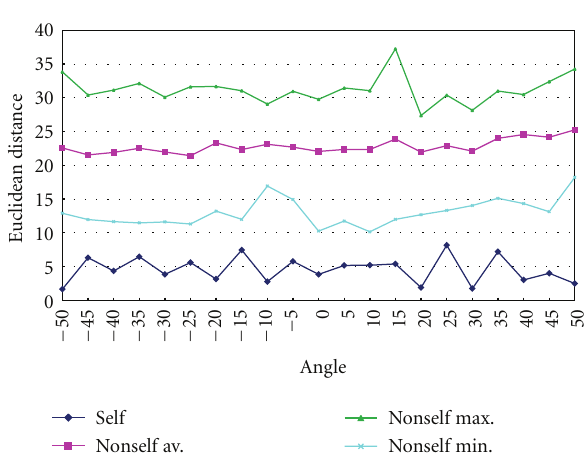
Figure 5: The results of distances between self and non-self-face image features at di ff erent angles of